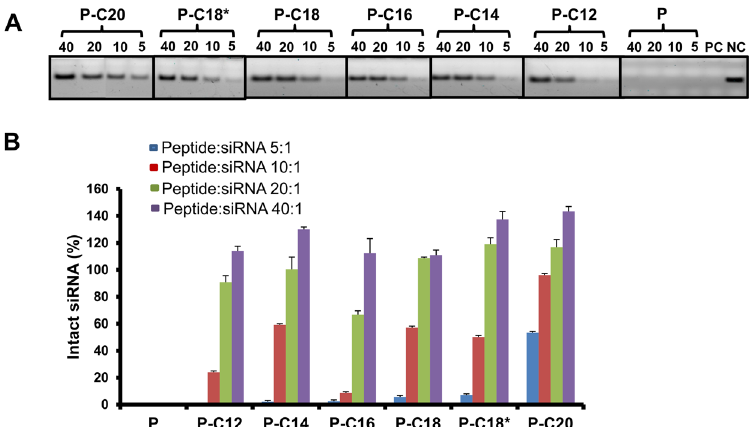
Figure 4. Serum stability of peptide:siRNA complexes. ( A ) Representative gel electrophoresis image of intact siRNA remaining after 24 h incubation with 25% FBS at 37 °C. PC = Positive Control representing free siRNA incubated with serum; NC = Negative Control (Quantified as 100%) representing free siRNA incubated with saline; ( B ) Quantification of intact siRNA remaining after 24 h incubation. Complete protection was observed for all modified peptides at w/w ratio of 20:1 (N/P ≈ 27.3), except for P-C16, which achieved that at ratio of 40:1 (N/P ≈